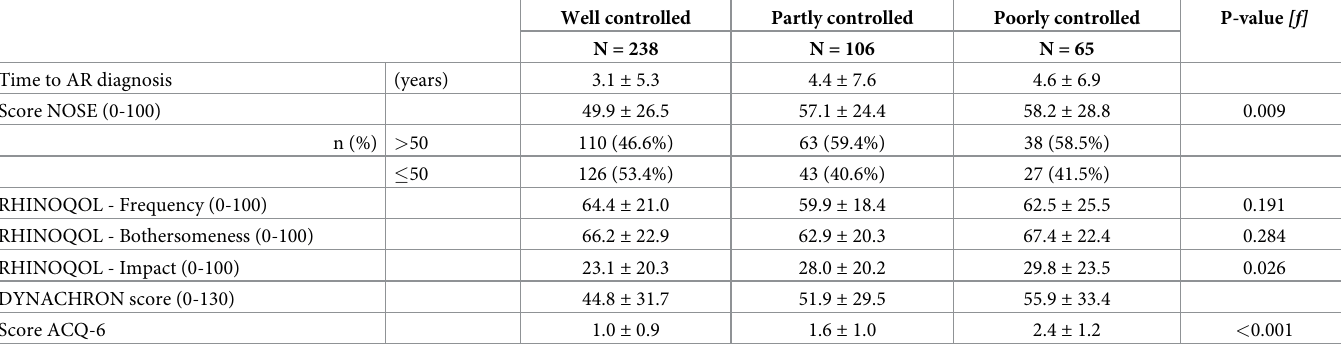
Table 5. Characteristics of patients suffering from AR and